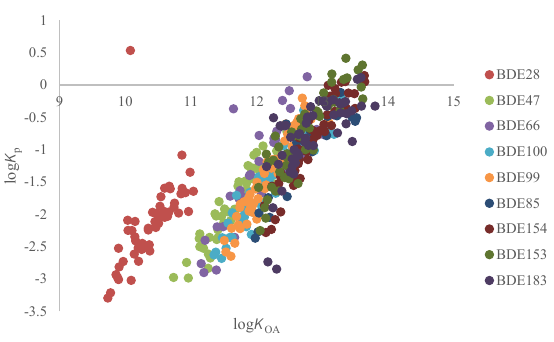
Figure 3. Influence of log K OA on measured log K p for individual